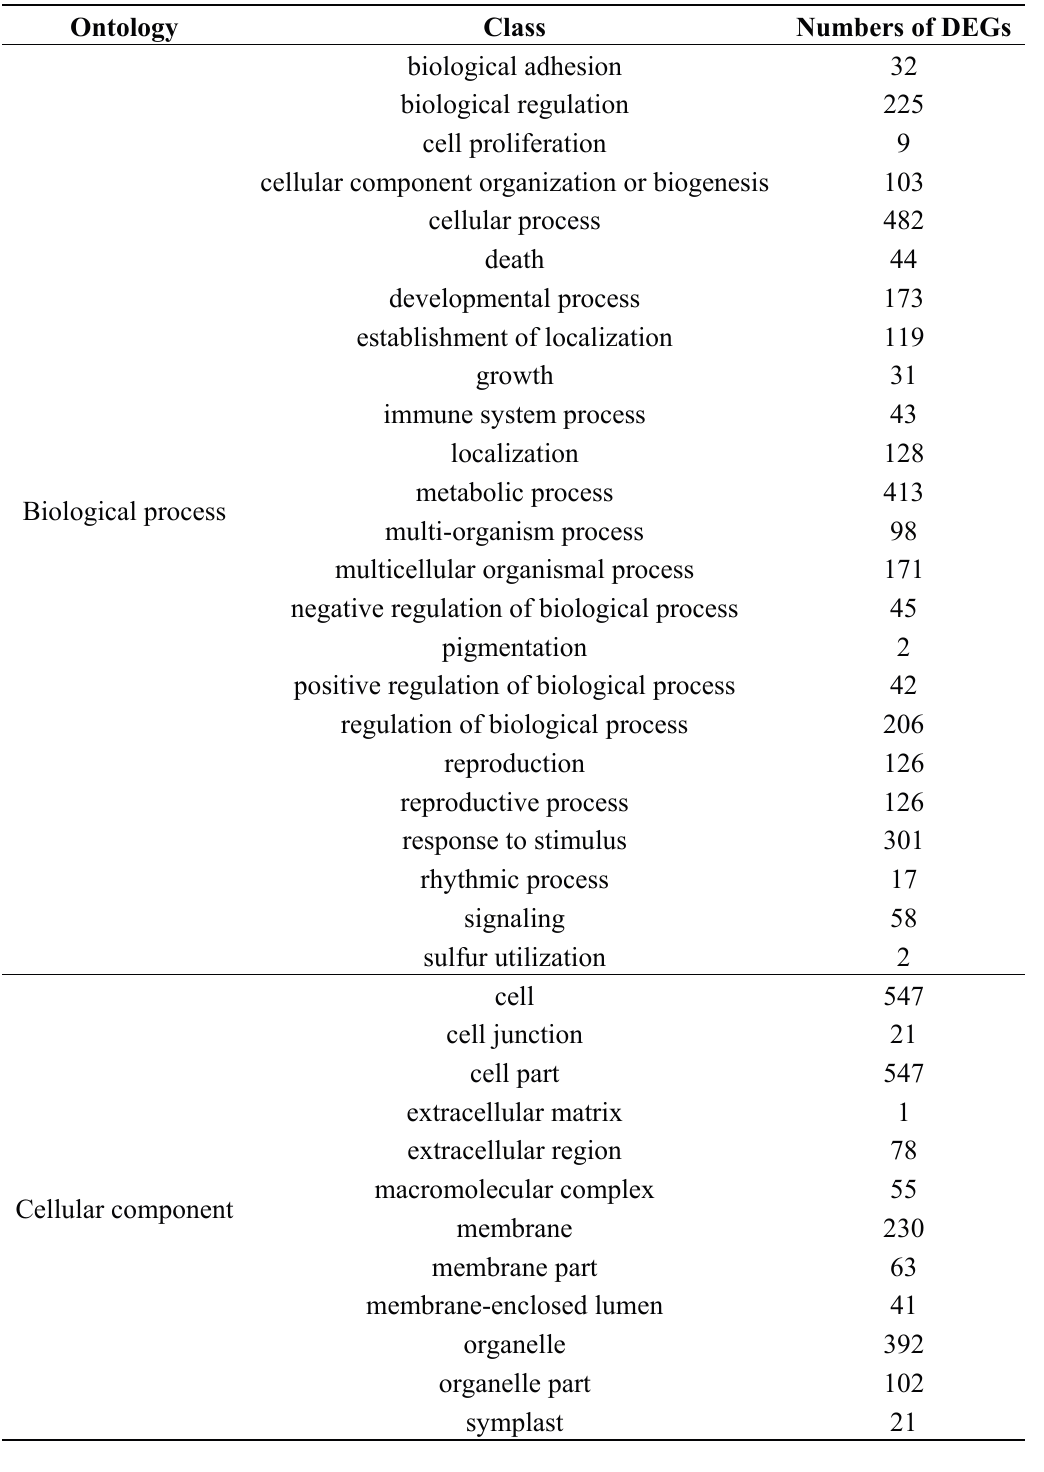
Table 4. GO function analysis results for the P. fortunei